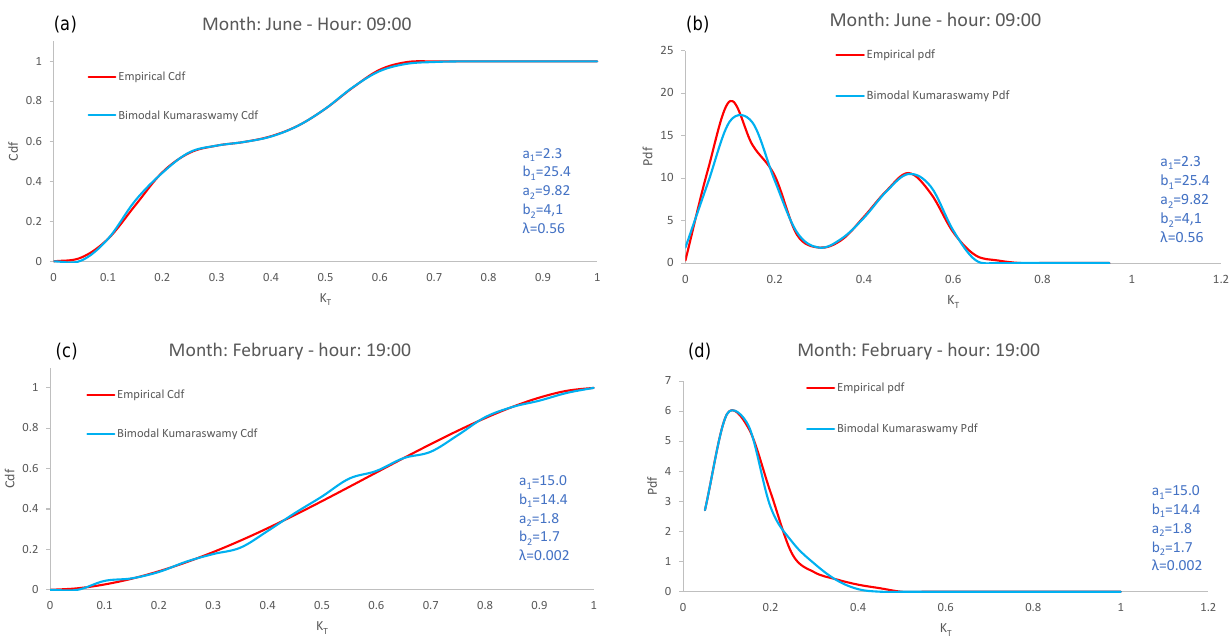
Figure 2. Examples of comparison between empirical and theoretical distribution, where the latter is a linear combination of Kumaraswamy distributions. (a, b) Psitallia station, Greece (bimodal); (c, d) Barrow station, Alaska (unimodal).